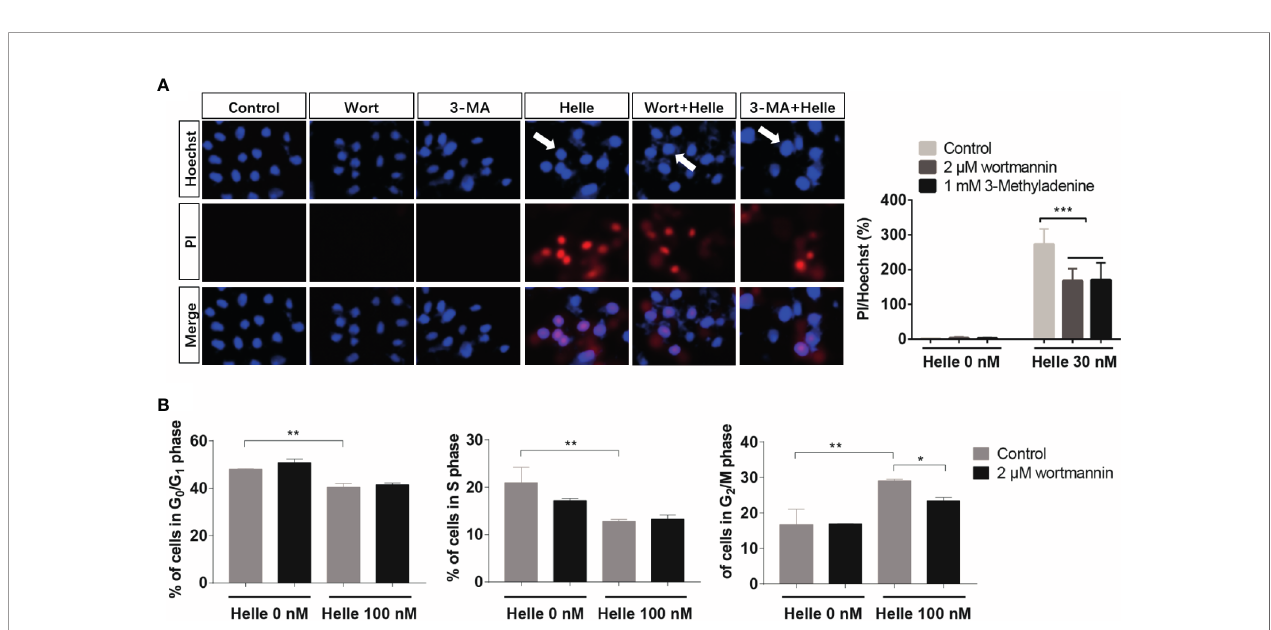
FIGURE 8 | Correlation between autophagy and apoptosis, necrosis as well as cell cycle arrest in MCF-7 cells treated with Helle. (A) After treatment for 48 h with 30 nM Helle in the absence or presence of 2 m M wortmannin or 1 mM 3-MA, the phenotypic features of cell death were evaluated using the Hoechst 33342 (blue)/PI (red) staining as described in Materials and methods. The pink fl uorescence represents the merged images of Hoechst 33342 and PI. Images were captured using a BZ-X800 Keyence fl uorescence microscope and Leica X software at 100×magni fi cation. (B) After treatment for 48 h with 100 nM Helle in the absence or presence of 2 m M wortmannin, cell cycle analysis was performed by the same manner as described in the legend of Figure 5 . Data are presented as the means ± SD from three independent experiments. *p < 0.05; **p < 0.01; ***p < 0.001. Helle, hellebrigenin; Wort,